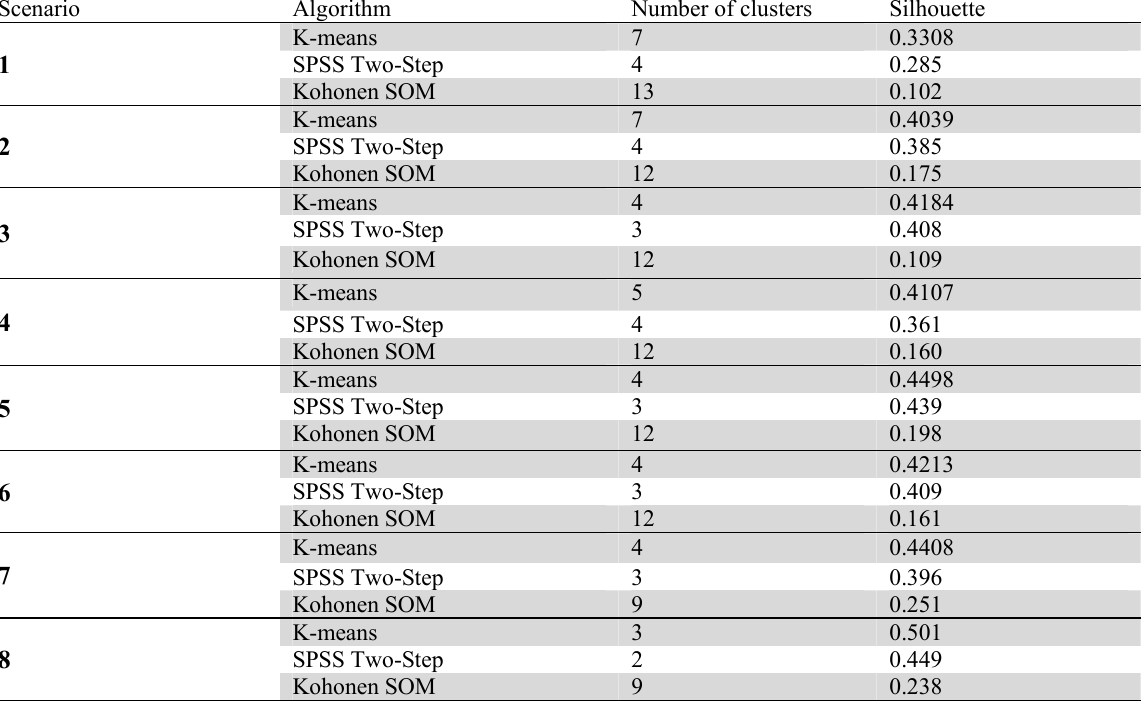
Fig. 7. Comparing silhouette values of K-means algorithm for all eight scenarios in situation 1 Comparison of the clustering algorithms for all eight scenarios in situation